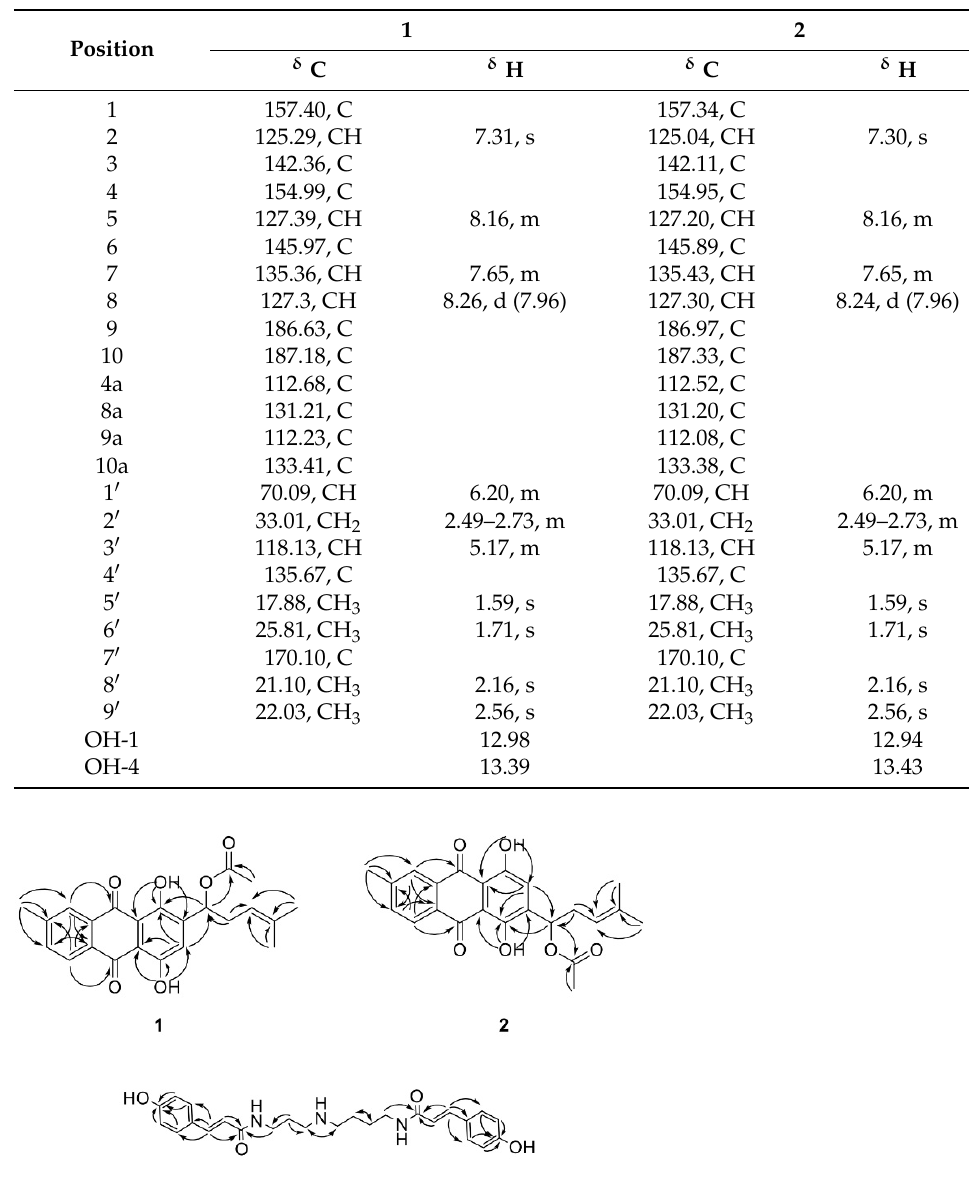
Table 1. 13 C and 1 H-NMR data for compound 1 and 2 (at 400 MHz for 1 H-NMR and 100 MHz for δ in ppm, J in Hz). 13 C-NMR in CD 3 OD,